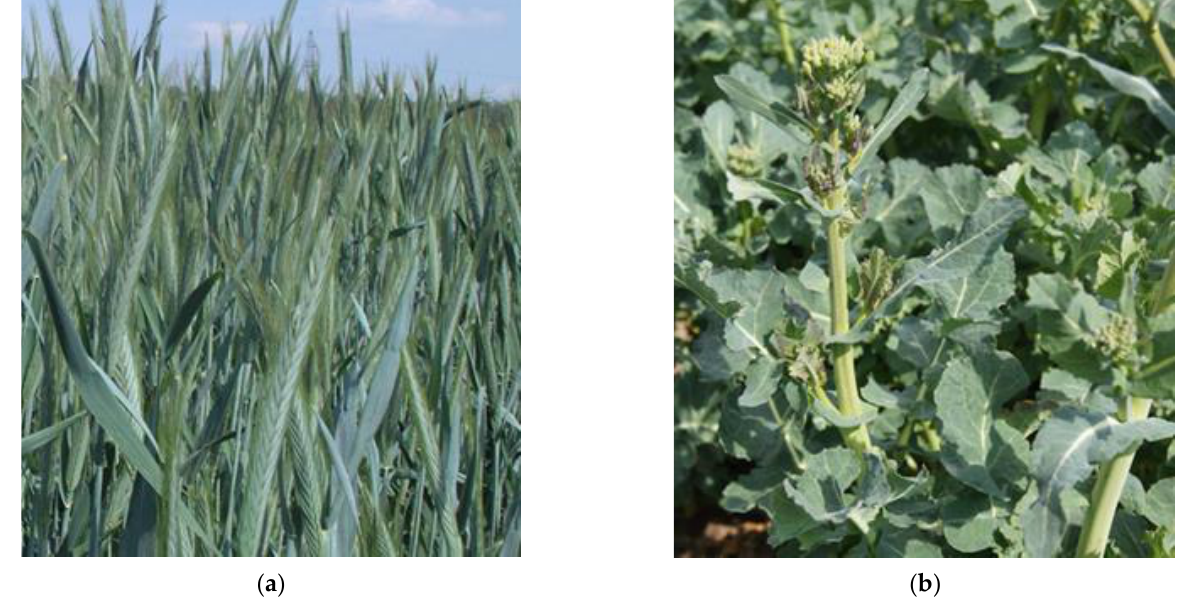
Figure 8. The Cardinal Stage 2 (CK2): winter rye (monocot) ( a ) and winter oilseed rape (dicot) ( b ). Photos by W. Grzebisz. ( b ). Photos by W.